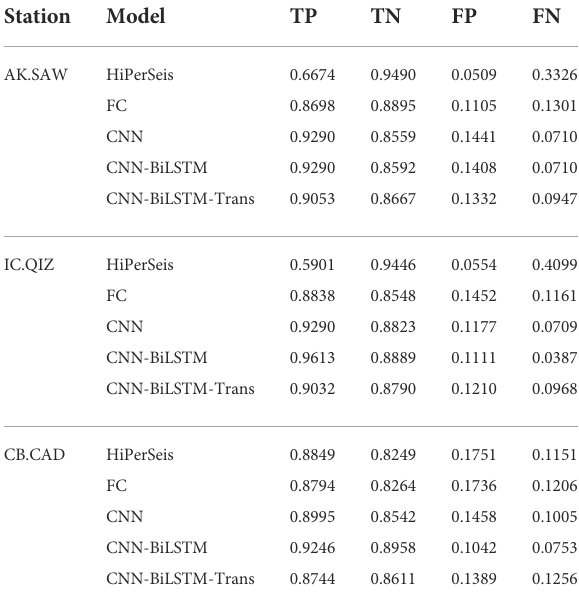
TABLE 2 Normalized confusion matrixes of the four deep learning models and traditional method (HiPerSeis) on three station